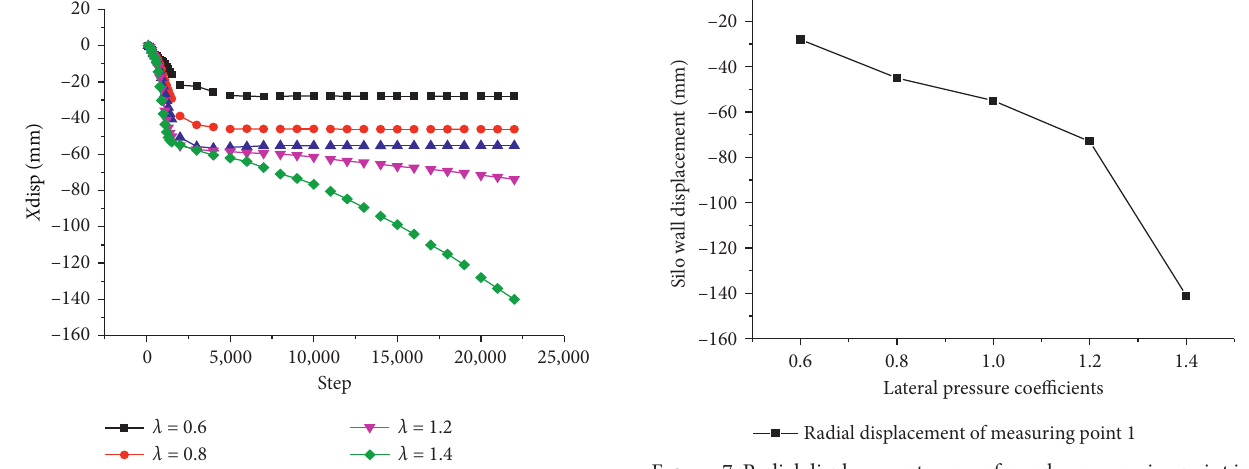
Figure 7: Radial displacement curve of number measuring point in the middle of the shaft wall.